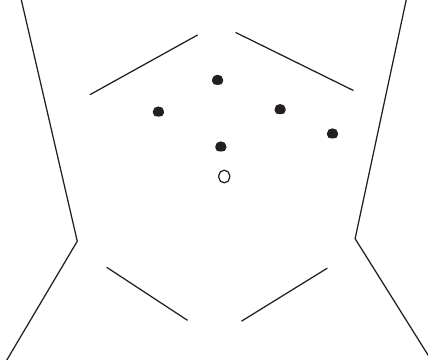
Figure 4: Schematic diagram showing trocar positions: three 5 mm trocars (right subcostal, subxiphoid, left lateral), one 10mm trocar (left subcostal), and one 15mm trocar (supraumbilical) are used.